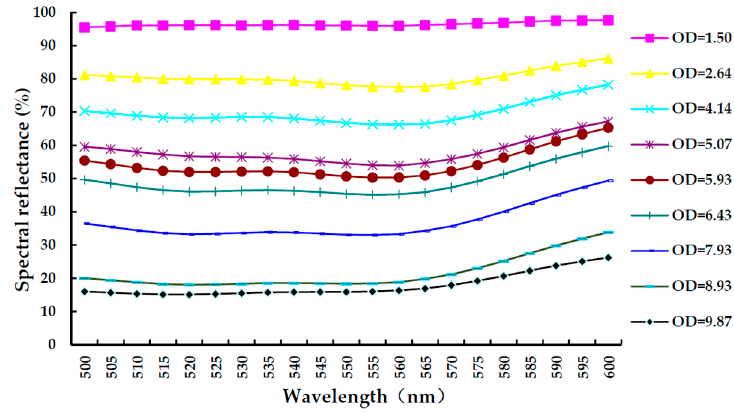
Figure 10. The spectral reflectance of test line of the printed calibration strips. Table 6. The calculated average spectral reflectance of the test line.